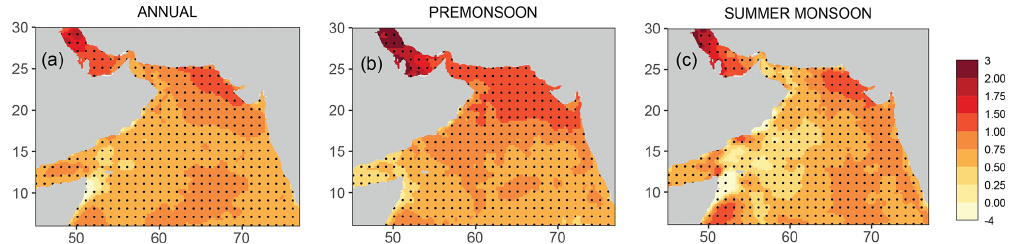
Figure 4. Trends of SST ( ◦ C per 37 years) over 1982–2019 for (a) annual, (b) pre-monsoon, and (c) summer monsoon period. Stippling show regions where the trend is 99% significant based on two-tailed t